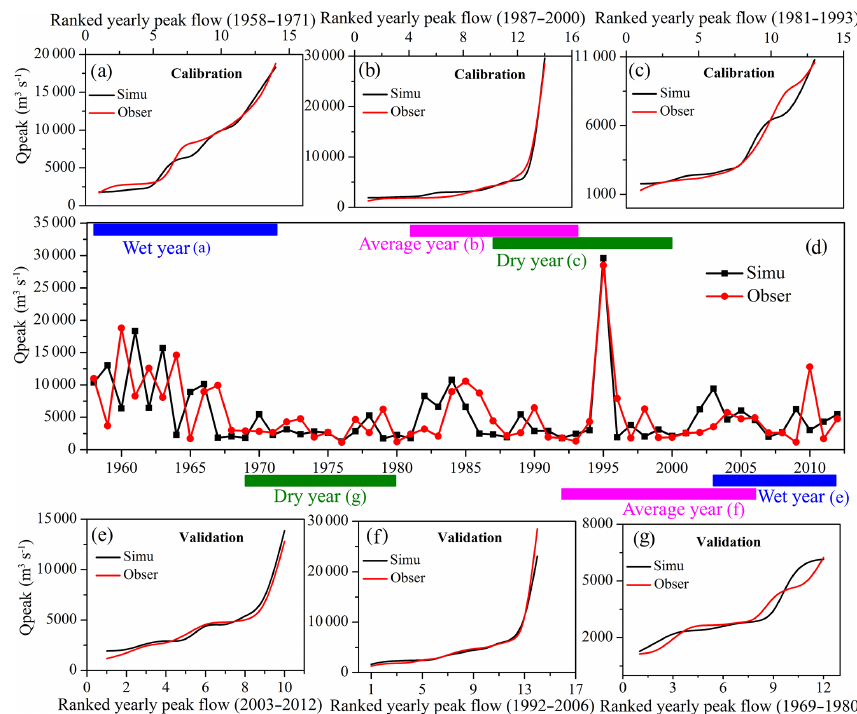
Figure 5. Comparisons of simulated and observed peak discharge of the Yalu River: (a–c) show ranked peak flows between the model simulations and observations for wet, average, and dry years during the calibration period, respectively; (e–g) show ranked peak flows between the model simulations and observations for wet, average, and dry years during the validation period, respectively; and (d) is the time-series comparison of simulated and observed daily peak flow during